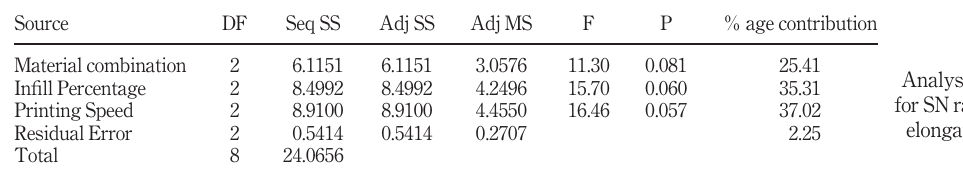
Figure 18. Linear model for SN ratios of pull out